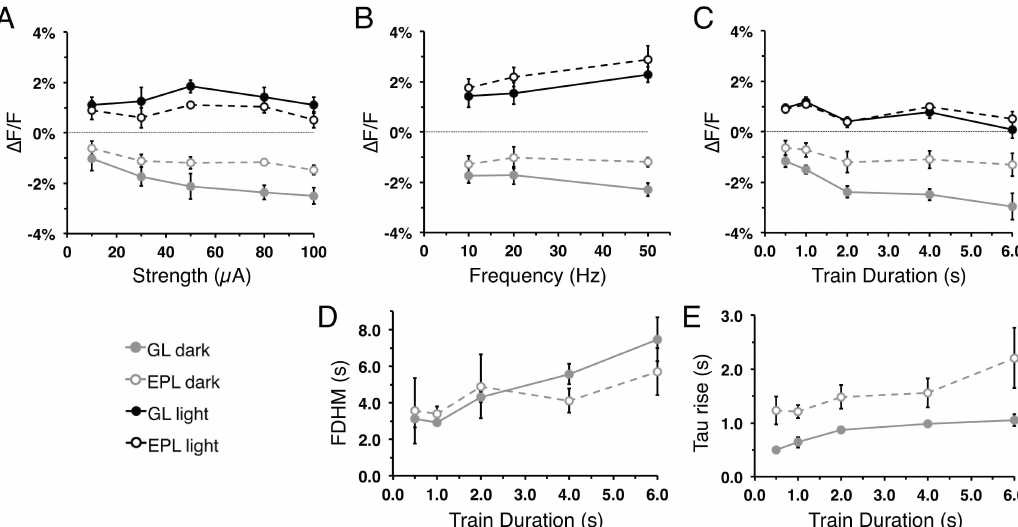
Fig 10. NAD(P)H signal response to changes in stimulation parameters. (A-C) Mean NAD(P)H signal peak (black) and trough (gray) in the GL (solid) and EPL (dash) as a function of train stimulus (A) strength, (B) frequency, and (C) duration. (A) Increasingthe stimulationstrength from 10 μ Ato 100 μ Awhile holdingthe other stimulationparameters constant (50 Hz, 2 s train, 100 μ s pulse) resulted in increaseddark phaseamplitudesin the GL (R 2 = 0.324, F (1,18) = 8.64, p < 0.01,n = 6) and EPL (R 2 = 0.266, F (1,18) = 6.51, p < 0.05,n = 6) amplitudes. (B) Increasingthe stimulationfrequency from 10Hz to 50Hz resultedin increaseddark phaseamplitudes in the EPL (R 2 = 0.352, F (1,14) = 7.61, p < 0.02,n = 6). (C) Increasingthe stimulationdurationfrom 0.5s to 6.0s resultedin increasedGL dark phase(R 2 = 0.520, F (1,18) = 19.49, p < 0.01,n = 6) and light phase(R 2 = 0.303, F (1,18) = 7.81, p < 0.02,n = 6) amplitudes. (D) NAD(P)Hsignal FDHM duration in the GL increasesas a function of train stimulus duration(R 2 = 0.267, F (1,18) = 6.56, p = 0.02, n = 6). (E) GL (R 2 = 0.619, F (1,18) = 29.19, p < 0.01,n = 6) and EPL (R 2 = 0.287, F (1,18) = 7.23, p < 0.02,n = 6) signalsexhibitincreasesin time-to- trough as a function of train